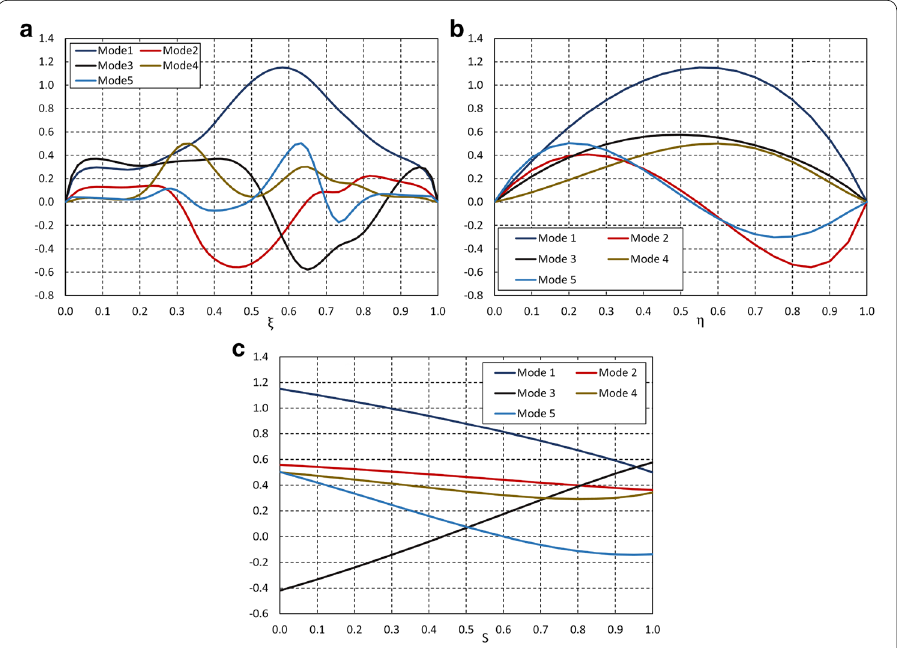
Fig. 25 Modes involved in the separated representation: a modes involving the coordinate ξ ; b Modes involving the coordinate η ; and c Modes involving the control point position S